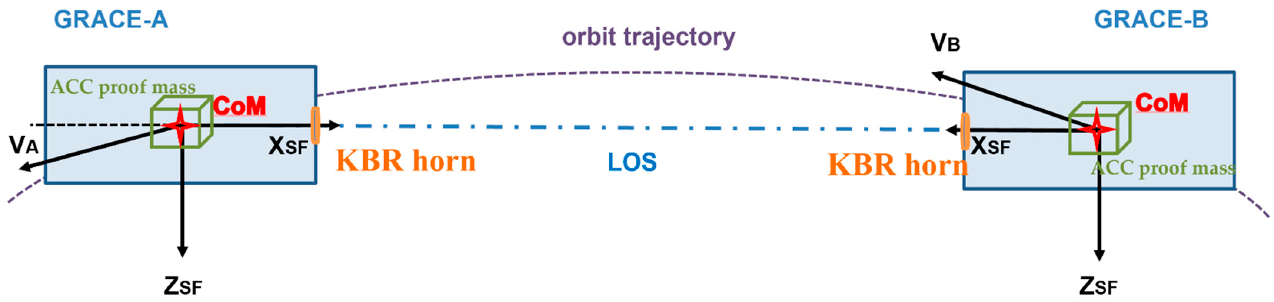
Figure 1. Geometric constraints among CoM, ACC proof mass center, and KBR horn of GRACE-A and GRACE-B. and